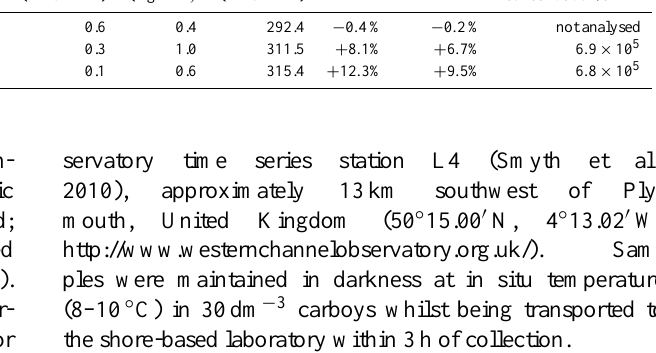
Table 1. Initial conditions of time series experiments. The oxygen supersaturation is defined as (cid:49) (O 2 ) = c( O 2 )/c sat ( O 2 ) − 1. The biological oxygen supersaturation is defined as (cid:49) (O 2 / Ar) = [ c( O 2 )/c( Ar ) ] / [ c sat ( O 2 )/c sat ( Ar ) ]− 1. Experiment